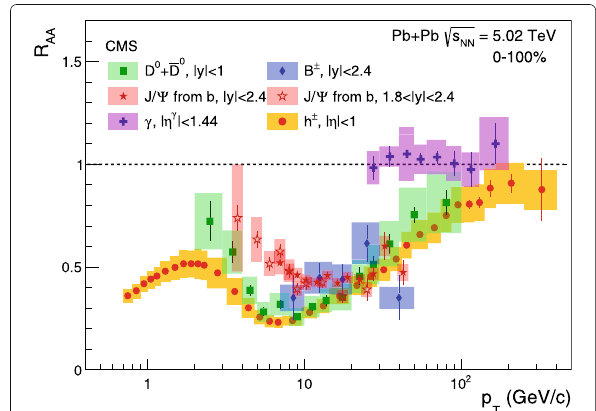
Fig. 4 Nuclear modification factor R AA for various particles as a function of the transverse momentum in Pb+Pb collisions at 5.02 TeV from the CMS experiment [16–20]